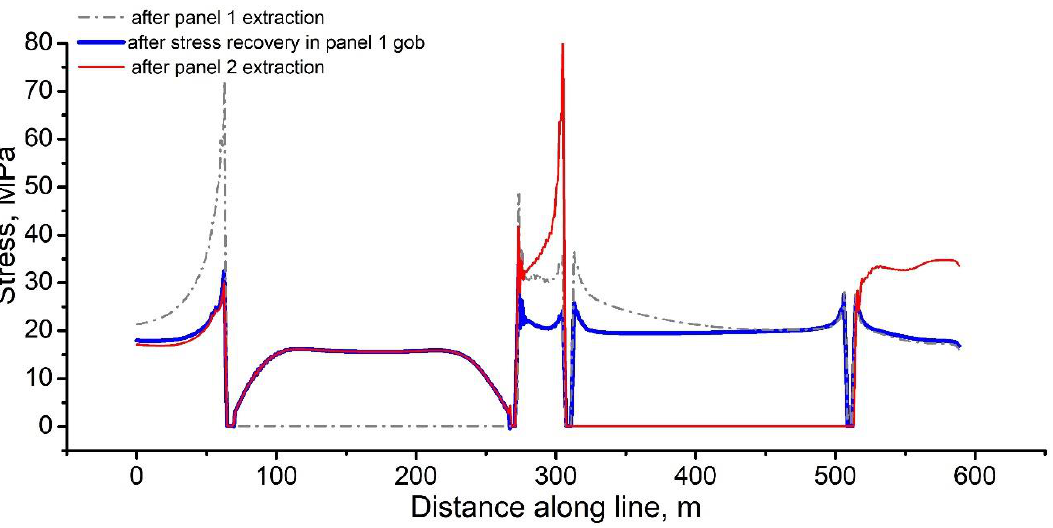
Figure 8. Distribution of vertical stress along the line drawn through the center of the model in the dip direction of seam 3.